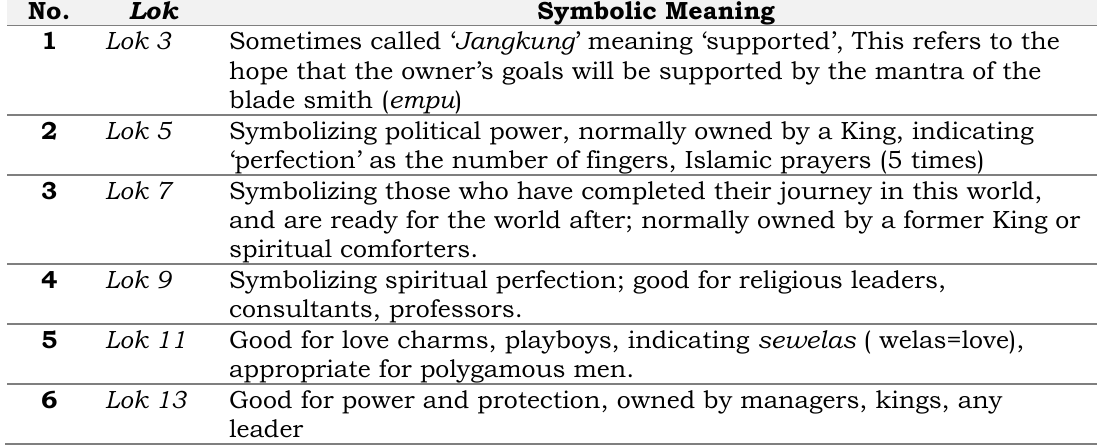
Table 2. Symbolic Meanings of Lok